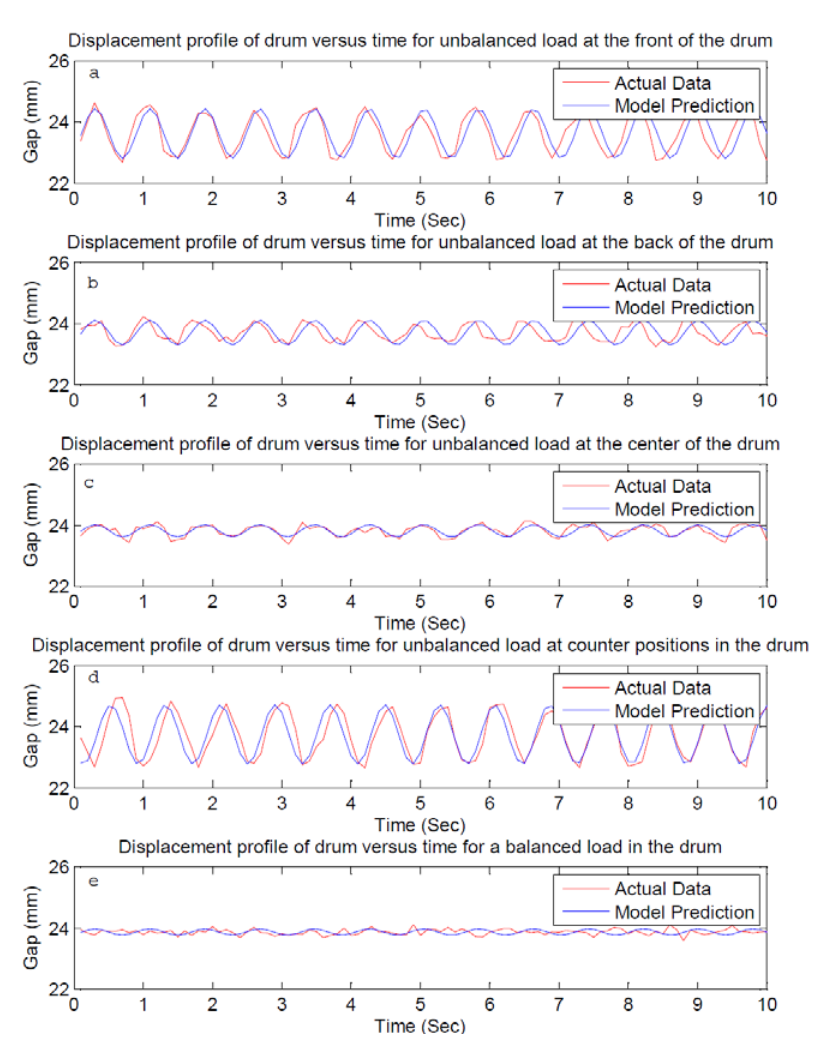
Figure 10. Displacement profile of drum versus time for unbalanced load at different